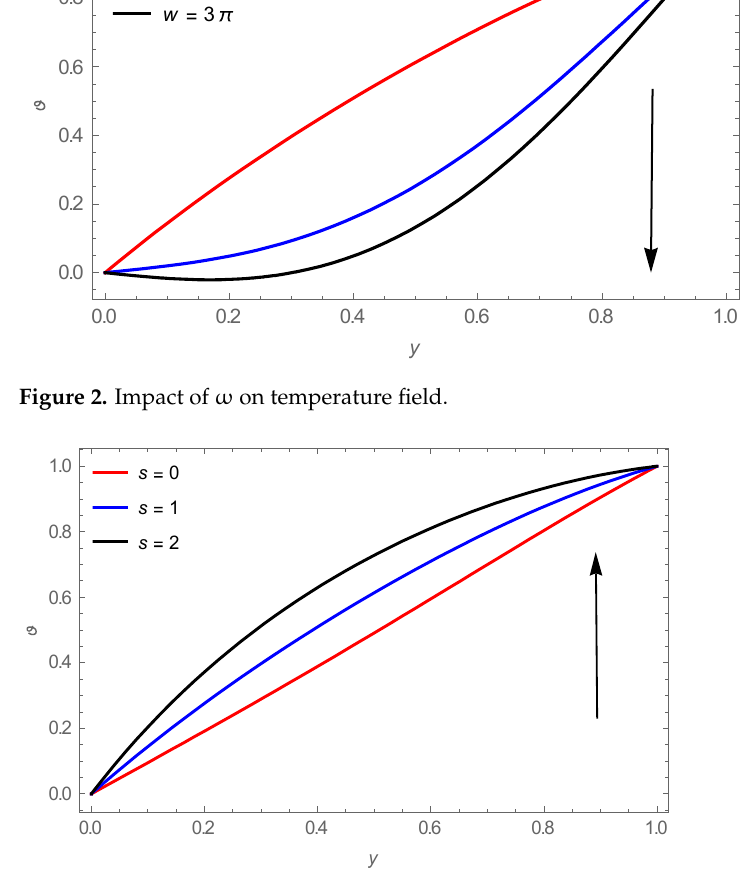
Figure 3. Impact of (cid:1845) on temperature field.